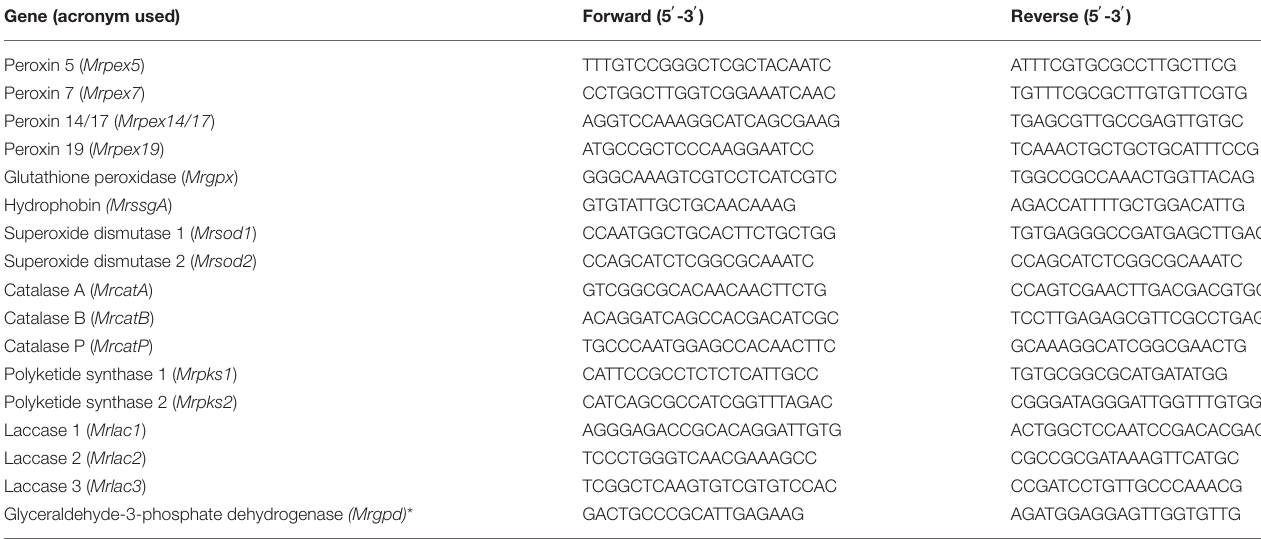
TABLE 2 | Oligonucleotides used in this